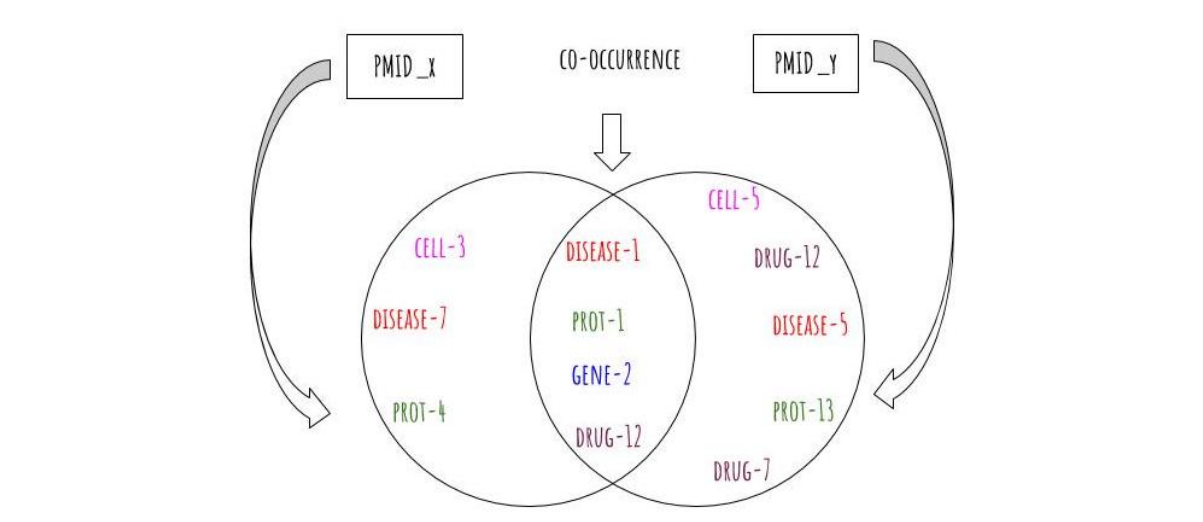
Figure 2. Two hypothetical PubMed Abstracts (PMIDx and PMIDy). Each abstract contributes some biological entities. The entities in the intersection namely (disease-1, prot-1, gene-2, and drug-12) contribute to a network of co-occurring entities that become the grounds for further exploration. In the presence of a larger data set of abstracts and more biological features, the network becomes an interesting ground for exploration and potential